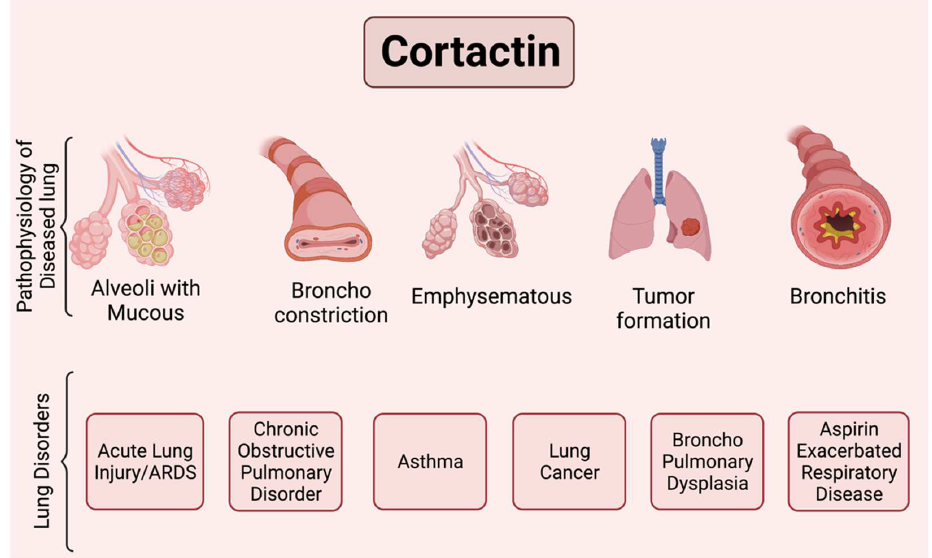
Figure 3. Scheme illustrating major lung pathologies mediated by cortactin.